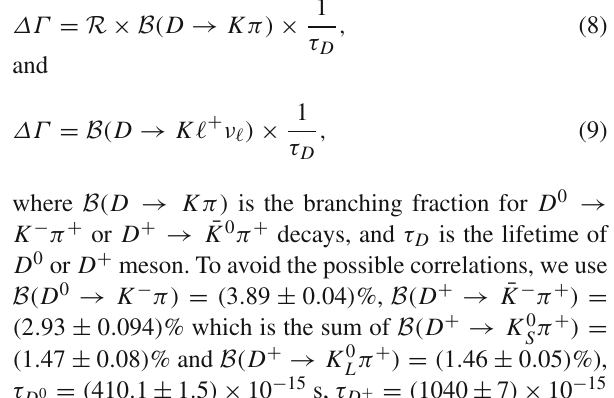
( D → K (cid:2) + ν (cid:2) ) measured at differ- 0 ( + )